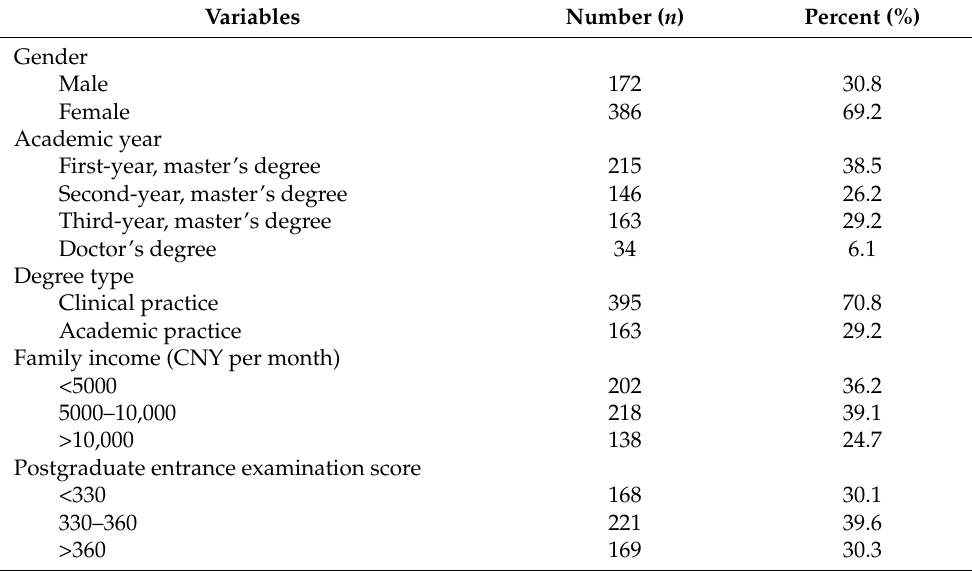
Table 1. Demographic characteristics of the